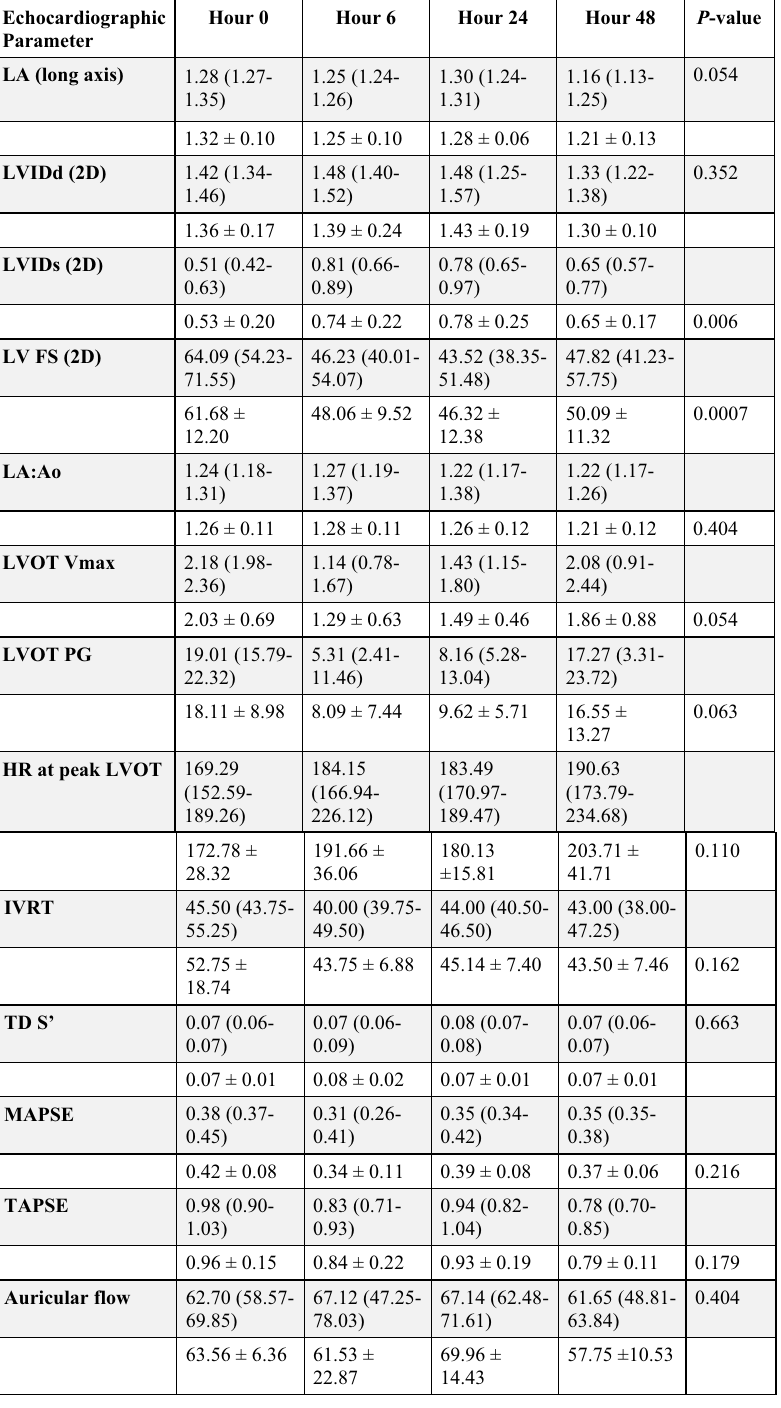
Table 4. Treatment group C: 1 mg/kg. Echocardiographic variables for the 1 mg/kg aficamten treatment group with reported mean ± standard deviation (unshaded rows) and median and interquartile range (shaded rows). The P value for variables that were statistically evaluated by either repeated measures one-way ANOVA or Friedman’s test are shown. LA left atrium, LVIDd left ventricular internal dimensions (diastole), LVIDs left ventricular internal dimensions (systole), LV left ventricle, FS fractional shortening, LVIDd left ventricular internal diameter (diastole), LVIDs left ventricular internal diameter (systole), LA/Ao left atrial-to-aortic root ratio, LVOT left ventricular outflow tract, Vmax velocity (maximum), PG pressure gradient, HR heart rate, IVRT isovolumic relaxation time, TD tissue Doppler, S’ mitral annular systolic velocity, MAPSE mitral annular plane systolic excursion, TAPSE tricuspid annular plane systolic